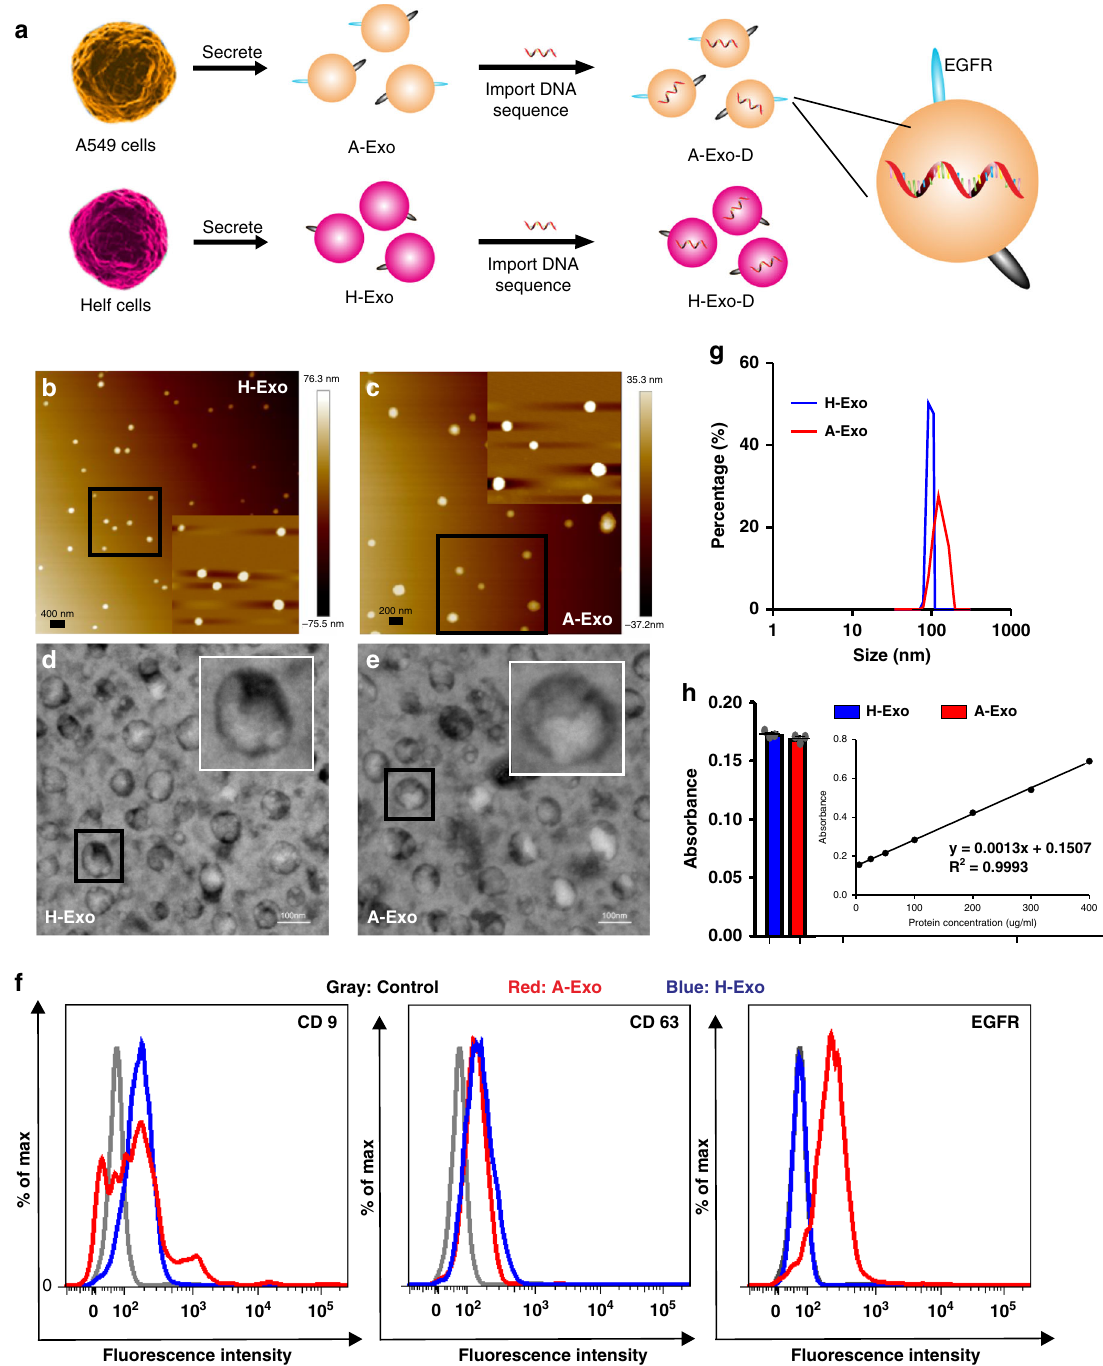
Fig. 1 Engineering and characterising extraneous exosomes. a Exosomes derived from either the human lung cancer cell line A549 (A-Exo expressing high EGFR) or the control human lung fi broblast cell line HELF (H-Exo) were isolated and transfected with a DNA sequence for quantitative analysis. b , c High- resolution atomic force microscopy (AFM) and d , e transmission electron microscopy (TEM) show the size and morphology of A-Exo and H-Exo, respectively, with an additional sixfold ampli fi cation in size (insets). f Flow cytometry analysis showing the expression levels of CD9 and CD63 on A-Exo and H-Exo with high EGFR expression on A-Exo only. g Size distribution and h protein quanti fi cation using the standard concentration curves of A-Exo and H-Exo ( n = 3 independent samples). Scale bars: 400 nm ( b ), 200 nm ( c ), 100 nm ( d , e ). Data presented as the mean ± s.e.m. Source data are provided as a Source Data fi